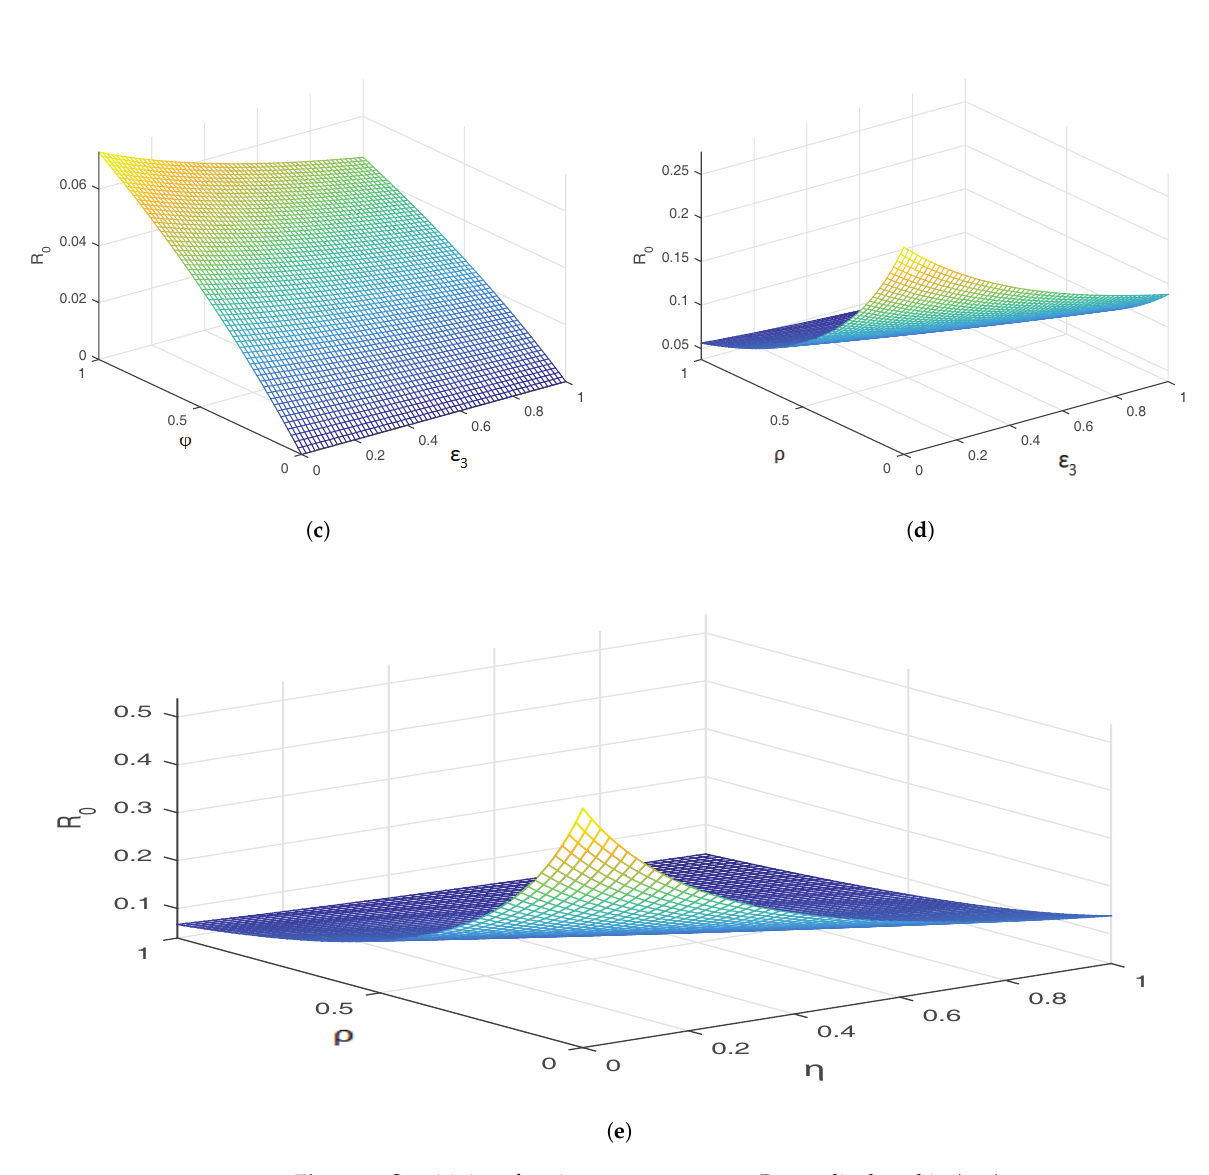
Figure 3. Sensitivity of various parameters vs. R 0 are displayed in ( a – e